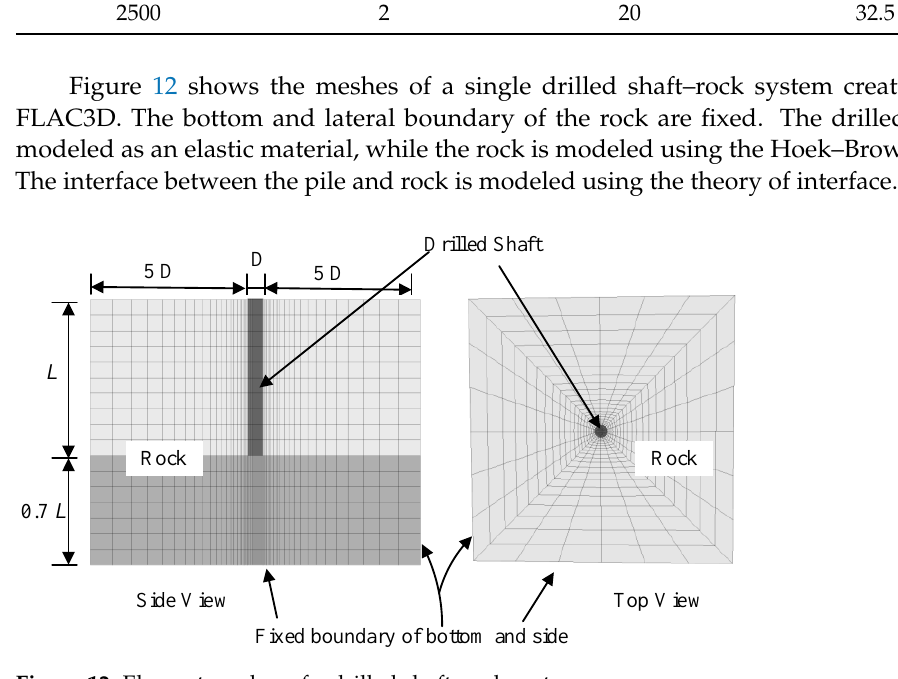
Figure 13. p – y curve of pile top.